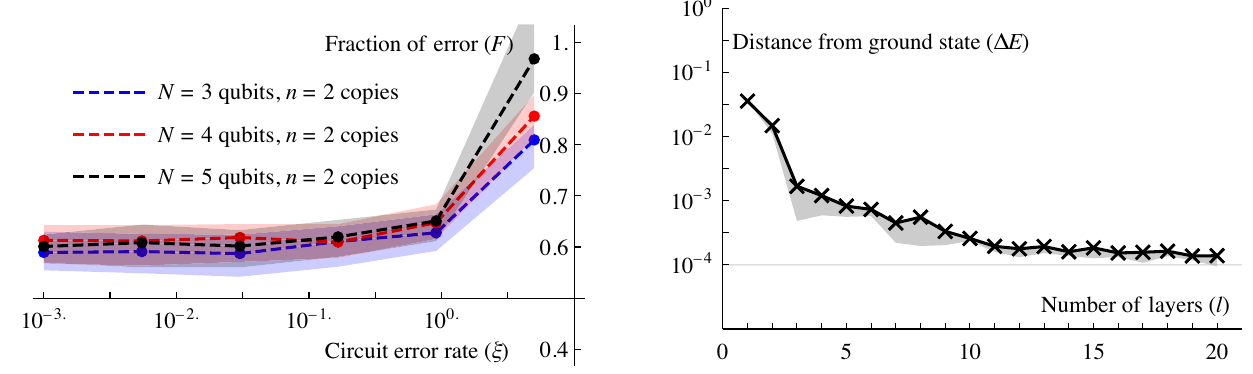
FIG. 10. Left: reducing errors in the derangement operator D 2 via generalized twirling operations as discussed in Appendix E 2. Errors ˜ E ) and without ( E ) in measuring expectation values of 50 randomly selected observables σ ∈ f Id 2 ; X; Y; Z g ⊗ N were computed with ( ˜ E = E twirling. The median of the ratios F of the two errors F ≔ is plotted as a function of the number of expected errors in the derangement circuit ( ξ ) — shading represents the quantiles 1 = 4 and 3 = 4 . Twirling reduces 30% – 50% of errors in the noisy derangement circuit, but it can be viewed as a worst-case scenario as discussed in Appendix E 2. Right: finding the ground-state energy E of the spin- ring Hamiltonian from Eq. (8) using the variational Hamiltonian Ansatz with l layers as discussed in Appendix F 3. The Ansatz parameters were optimized in 5 independent instances and the average of the distance from the ground-state energy Δ E is plotted as a function of l . Shading represents the minimum of the 5